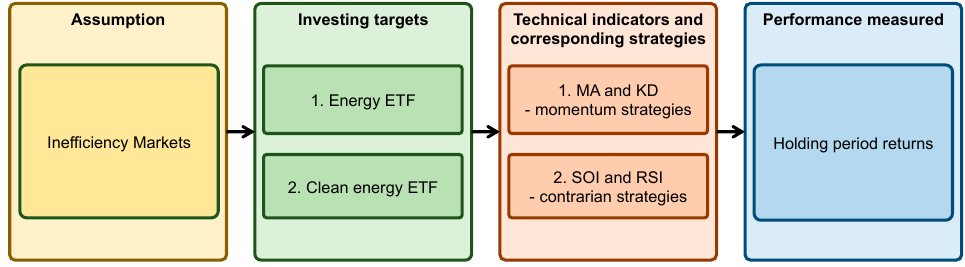
Figure 1. The conceptual framework of this study.